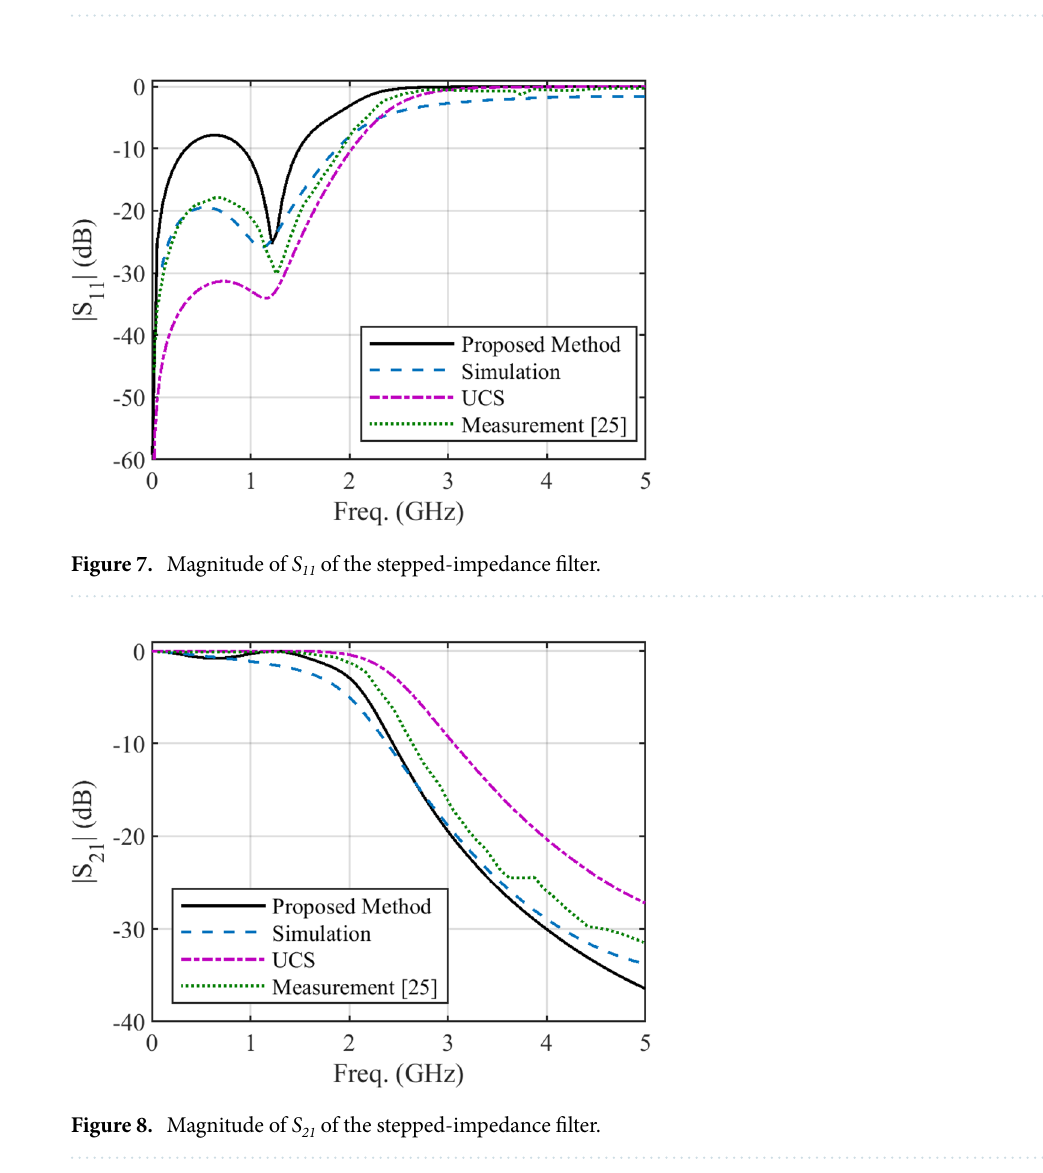
Figure 6. The picture of fabricated stepped-impedance filter (unit: mm) 25 .